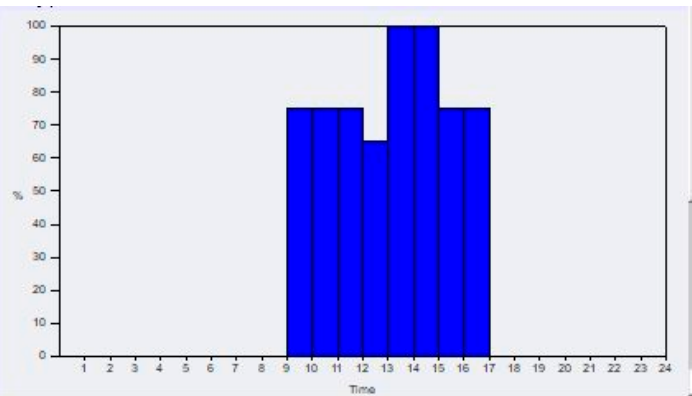
Figure A7. Tuesday Occupancy Pattern (input to BES).